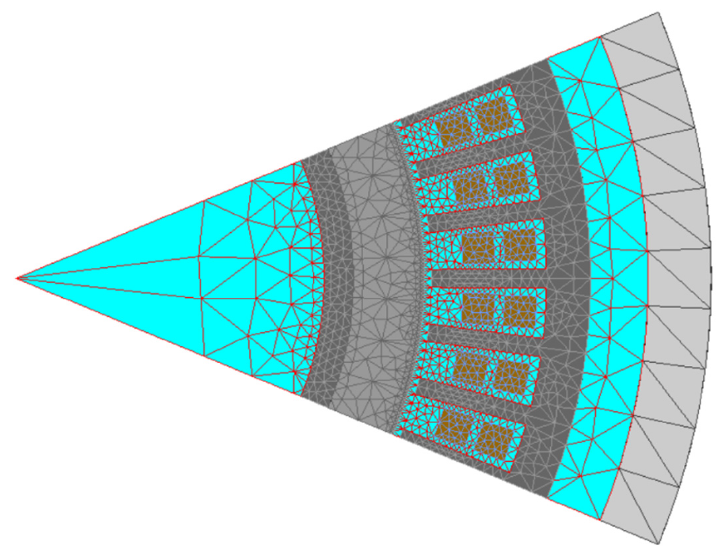
Figure 14. Mesh of the optimized motor.